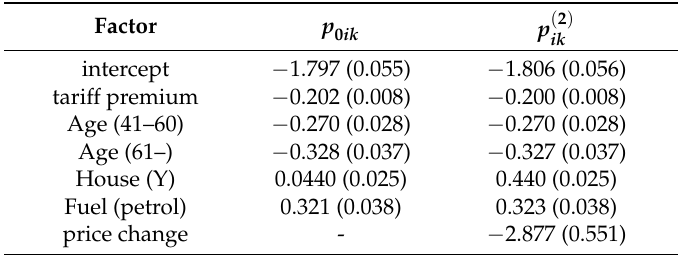
Table 2. Estimated logistic regression parameters for the two alternative sales probability models. Standard error for the parameter estimates are in